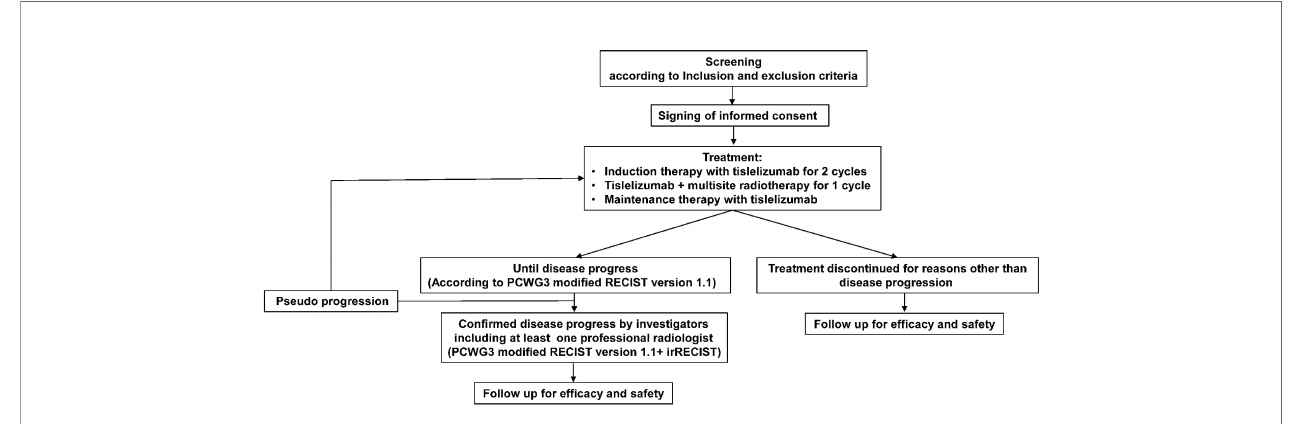
FIGURE 1 | Flowchart of this study. PCWG3, Prostate Cancer Working Group 3; RECIST version 1.1, Response Evaluation Criteria in Solid Tumors version 1.1; irRECIST, Immune-related Response Evaluation Criteria in Solid Tumors.